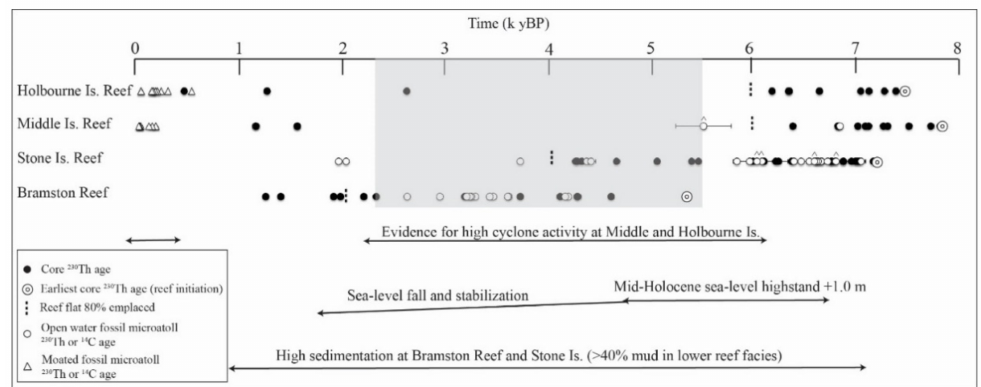
Figure 2. Timeline showing the main period of Holocene reef development for the four study areas. Uranium-thorium (U-Th; 230 Th) and radiocarbon ( 14 C) ages are those obtained from within reef cores and fossil microatolls. Re-calibrated 14 C ages from other sources are also presented with two sigma age errors and are denoted by ˆ (ages initially presented in [53,54] and re-calibrated using Calib 7.0 [55]). Note age errors are too small to warrant inclusion for the 230 Th ages. The Perry and Smithers [28] ‘reef-growth initiation hiatus’ period is shaded grey.